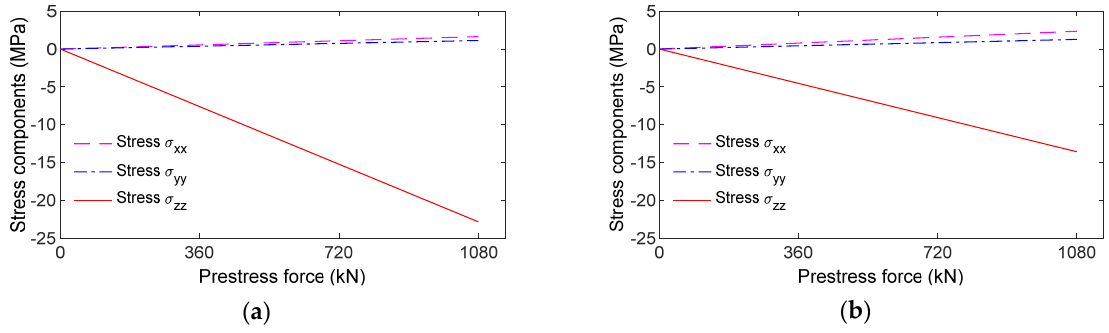
Figure 3. Stress responses versus applied force 0~9 PS in prestressed anchorage zone: ( a ) Point L1; ( b ) Point L2.